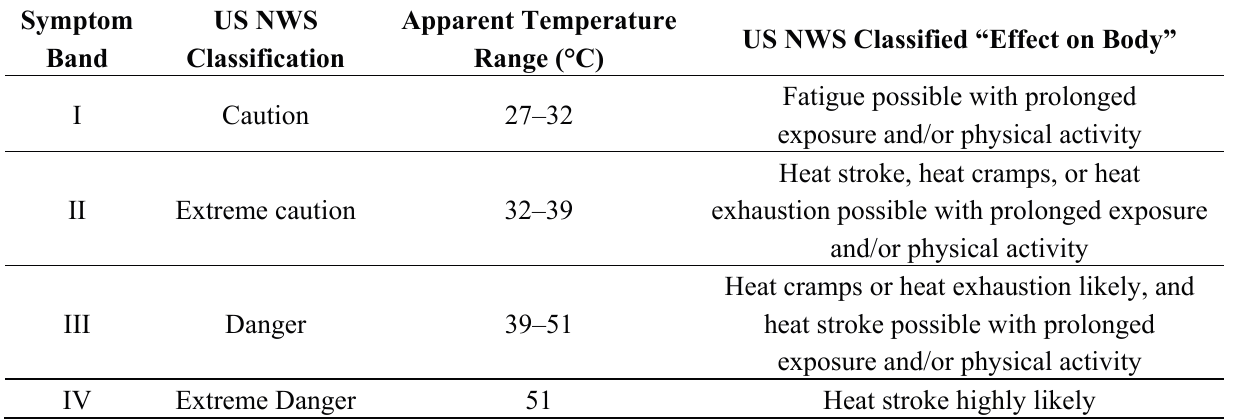
Table 1. Apparent temperature thresholds and potential health impacts